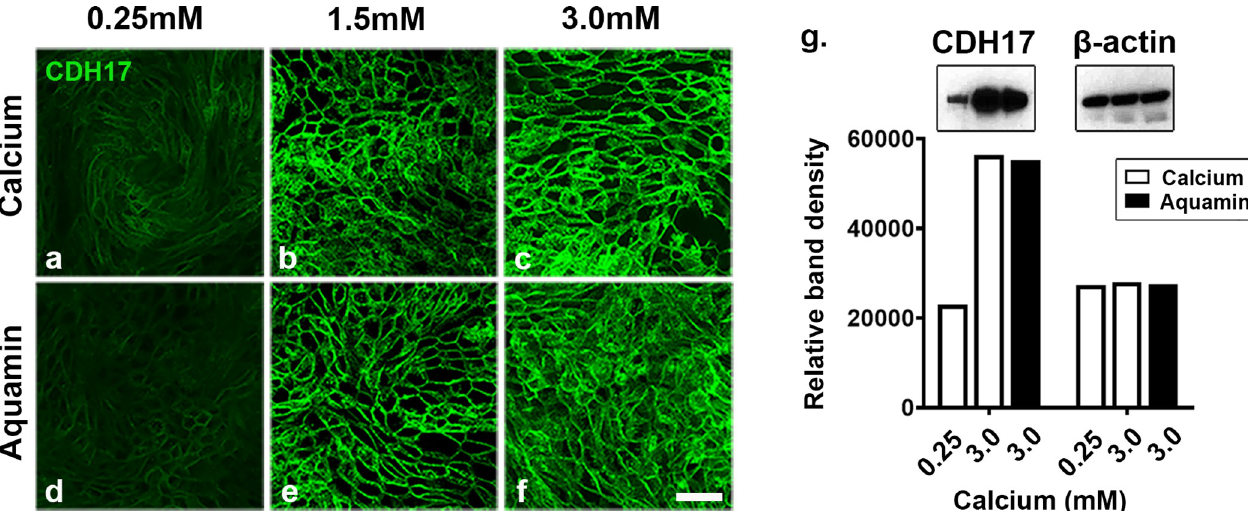
Fig 4. Evaluation of cadherin-17 expression by confocal fluorescent microscopy and western blotting. Colonoids were plated on transwell membranes and treated as indicated. a-f : Confocal fluorescence microscopy. After TEER assessment at day-5, membranes were prepared and stained for cadherin-17 expression (max projected). Scale bar = 10 μ m. g : Protein isolated from each condition was assessed for cadherin-17 expression by western blotting. 10 μ g of protein from each condition was used. β -actin was used as a loading control. Band quantitation was done using ImageJ software. CDH17 = cadherin-17.